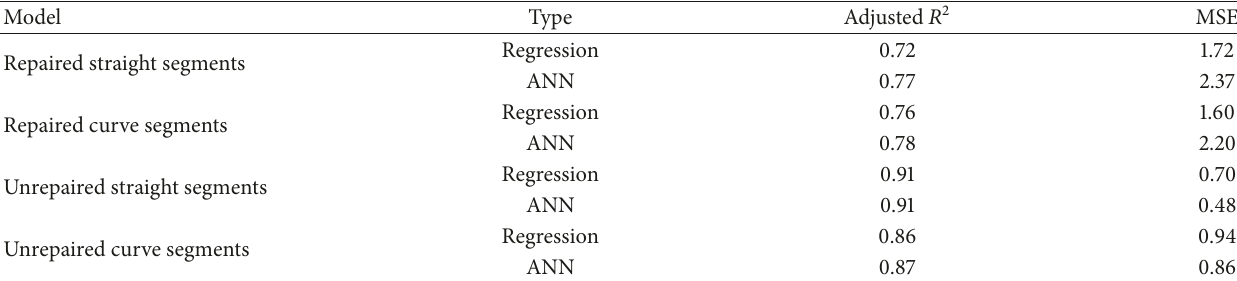
Table 6: Comparison of